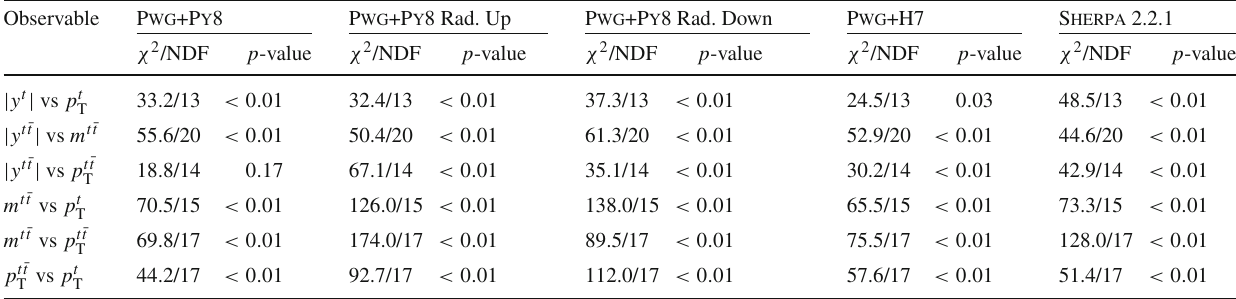
Table 22 Comparison of the measured parton-level absolute double- differential cross-sections in the resolved topology with the predictions from several MC generators. For each prediction a χ 2 and a p -value are